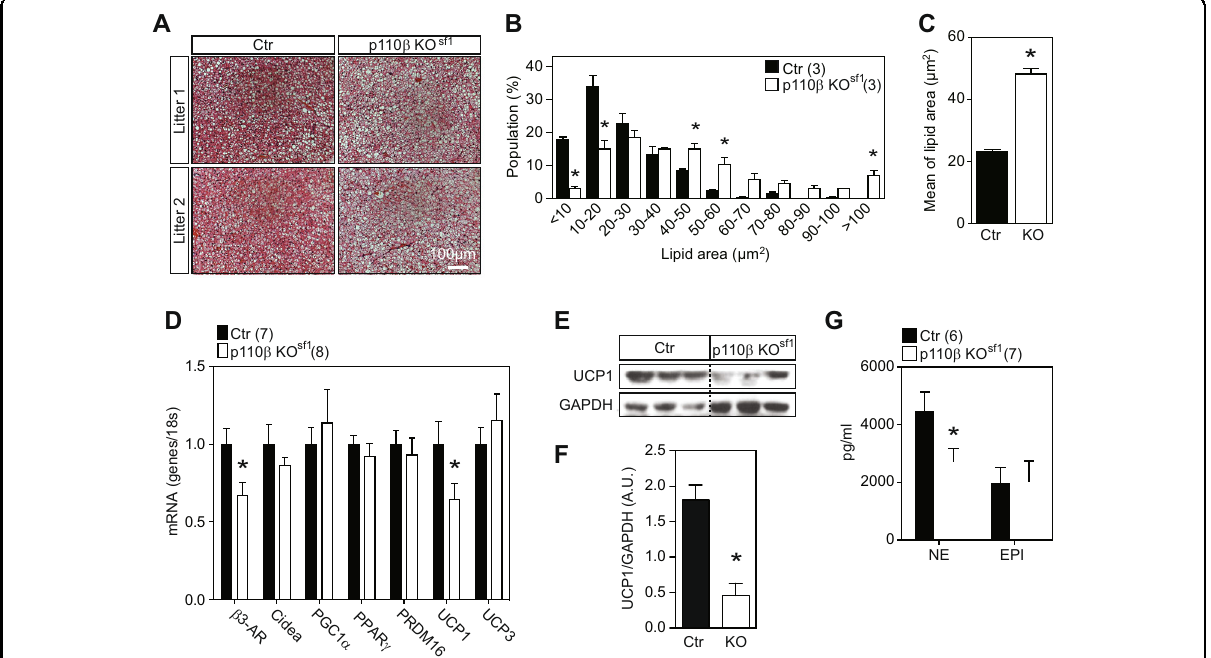
Fig. 3 Deletion of p110 β in SF-1 neurons leads to the whitening of iBAT. a Hematoxylin and eosin staining of iBAT from control and p110 β KO sf1 mice. b Distribution (% of population) of lipid droplets from a [signi fi cant interaction (two-way ANOVA, F 1.20 = 18.02, p = 0.0001)]. c Mean lipid area ( μ m 2 ) of the droplets from a . d mRNA levels of genes in iBAT regulating BAT programming. e UCP1 protein levels in the iBAT of control and p110 β KO sf1 mice. f Average UCP1 protein levels in the iBAT of control and p110 β KO sf1 mice. g Plasma norepinephrine and epinephrine levels in chow-fed males. Number of mice in each group is indicated in the legends or directly in the fi gures. Data are shown as the mean ± SEM. * P < 0.05 by Student ’ s t -test. EPI, epinephrine; Ctr, control; NE,